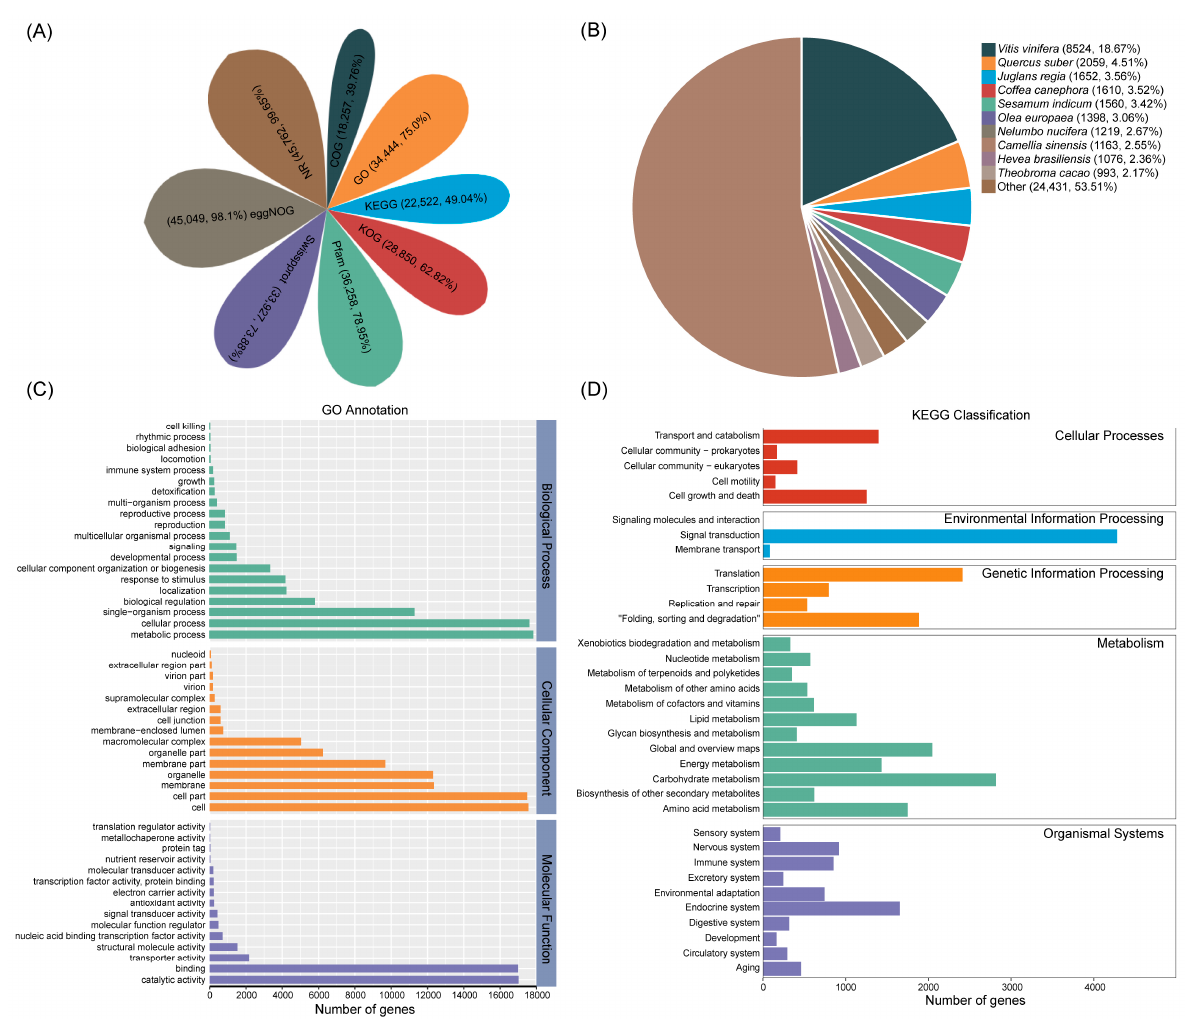
Figure 2. ( A ) Function annotation of the assembled full-length transcripts in the Nr, COG, eggNOG, GO, KEGG, KOG, Pfam, and Swissprot databases. ( B ) The distribution of homologous species annotated in NCBI nonredundant protein sequences. ( C ) GO annotation of the assembled full-length transcripts in A. arguta cv. Qinziyu. ( D ) KEGG classification of the assembled full-length transcripts in A. arguta cv. Qinziyu.